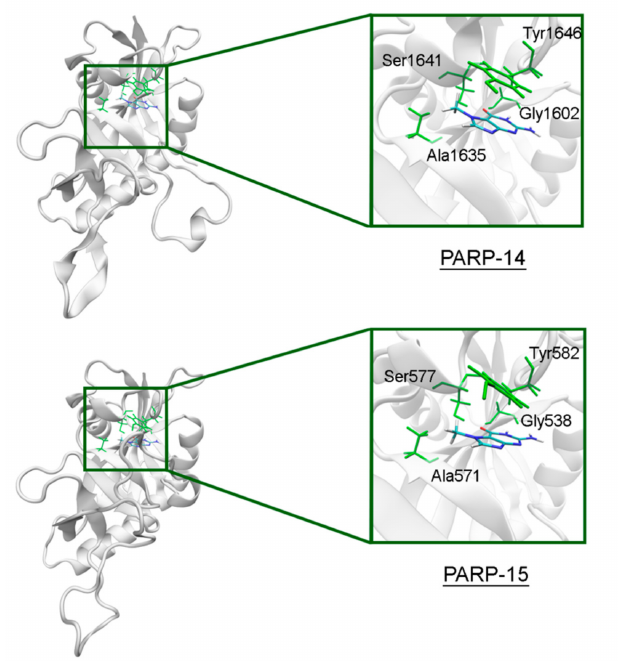
Figure 8. 7-MG position in the NA binding site of PARP-14 and 15 obtained using MD modeling. The NA site residues are colored in